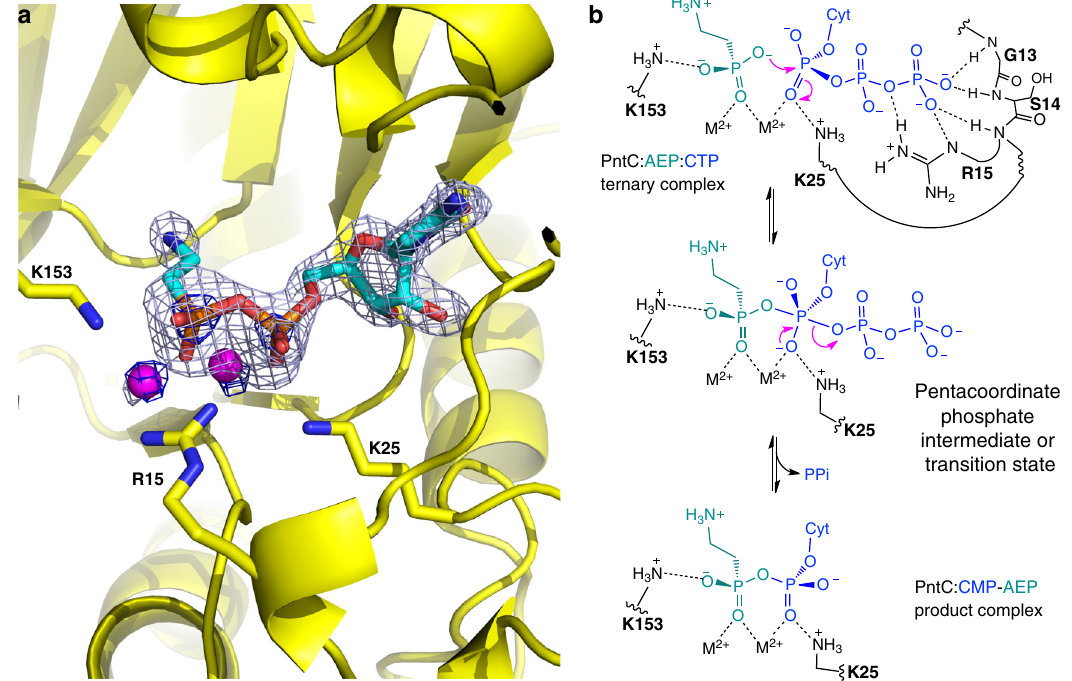
Fig. 6 Proposed mechanism of PntC. a CMP-AEP electron density (gray mesh: Fo-Fc omit map contoured at 3.5 sigma; blue mesh: 2Fo-Fc map contoured at 5.0 sigma highlighting the heavier Mg and P atoms) for the Tde-PntC:CMP-AEP complex. b Mechanistic interpretation of the crystallographic data. The proposed ternary complex structure (top) with extensive interactions stabilizing the PPi leaving group of CTP (blue). Nucleophilic attack of AEP (teal) generates a pentacoordinate phosphate intermediate or transition state possessing additional negative charge stabilized by Lys25 (middle). In the absence of obvious candidate general base residues, we propose that active site p K a perturbations may result in the deprotonated AEP substrate shown. Loss of PPi generates the CMP-AEP product bound in the active site (bottom) as seen in the crystal structure in